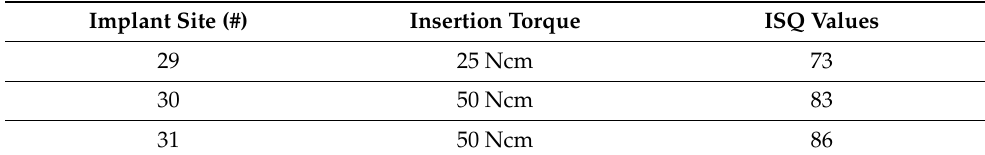
Table 1. Insertion torque and ISQ values.